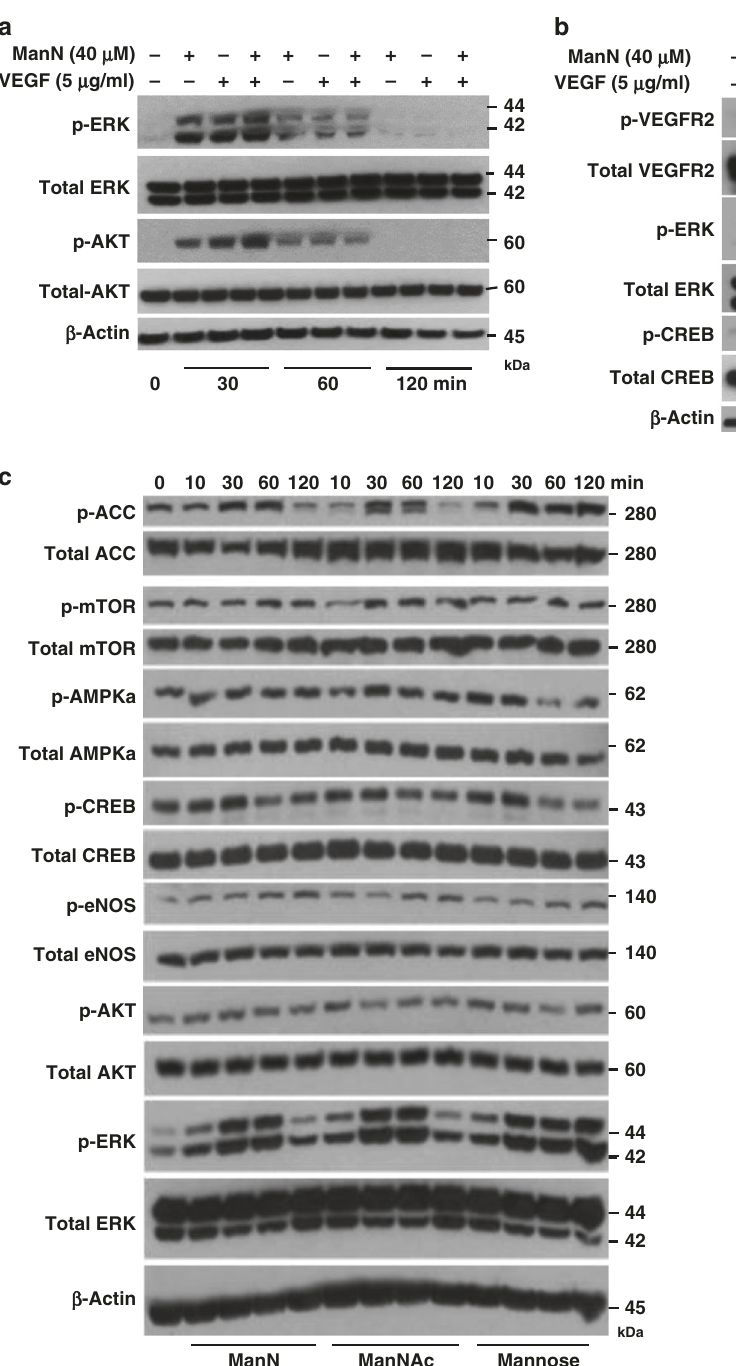
Fig. 2 Activation of ERK, AKT, mTOR, AMPK α , CREB, ACC, and eNOS is not unique to ManN. Enhanced activation of ERK (Thr 202/Tyr 204), AKT (Ser 473), and CREB (Ser 133) in BCECs following treatment with ManN together with VEGF for various times ( a ) or following pre-treatment with ManN for 8 h, followed by VEGF stimulation for 15 min ( b ). c BCECs were treated with 40 μ M ManN, ManNAc, or mannose for various times. Total mTOR, ACC, eNOS, AMPK α , ERK, AKT, CREB as well as phosphorylation of mTOR (Ser 2448), ACC (Ser 79), eNOS (Ser1177), AMPK α (Thr 172), ERK (Thr 202/Tyr 204), AKT (Ser 473), and CREB (Ser 133) were examined by western blot analysis. β -actin served as the loading control. Molecular weight (kDa) was labeled at the right. A representative experiment is shown from two independent studies. Data are provided as a Source data fi